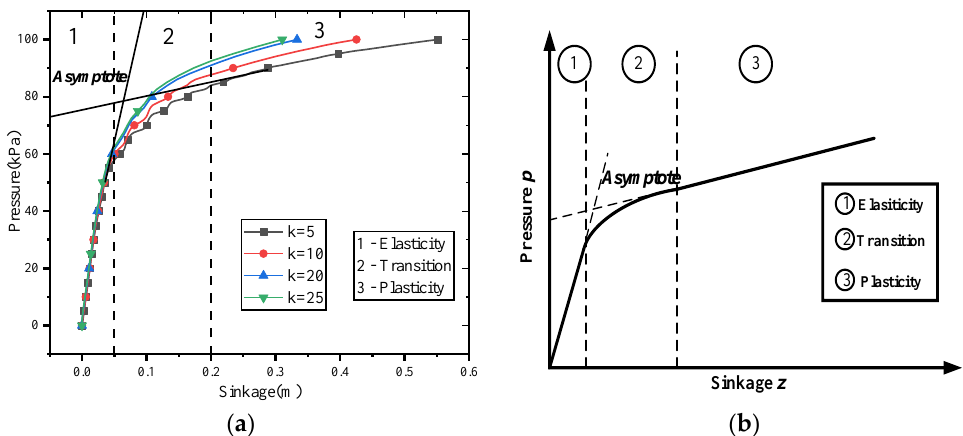
Figure 13. Comparison between the numerical simulation ( a ) Simulation results, and the plate sinkage test, ( b ) test results [18].